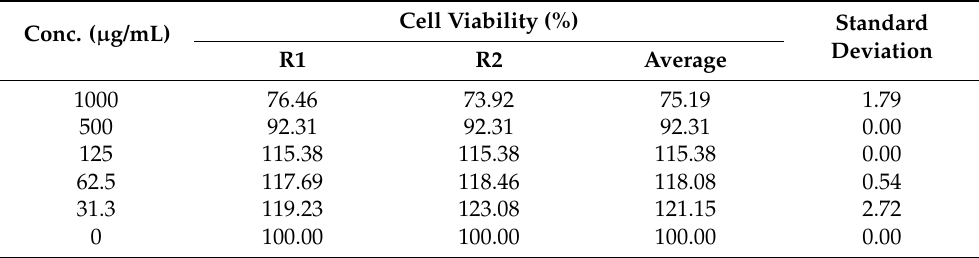
Table 3. Effect of M. longipetala extract at different concentrations on cell viability based on HepG2 cancer cell line.